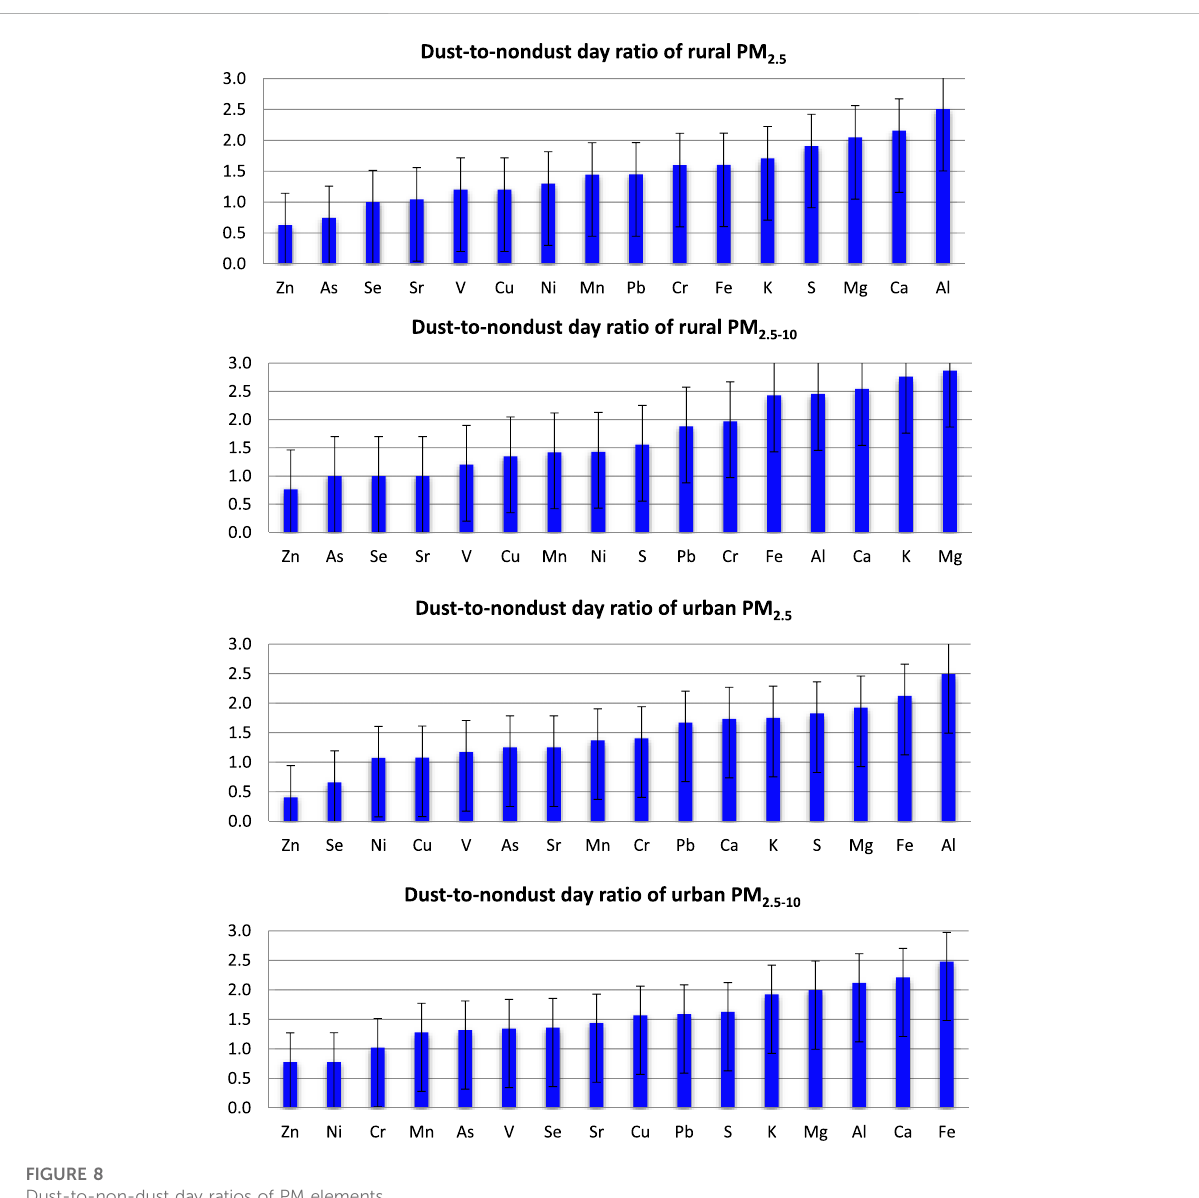
Dust-to-non-dust day ratios of PM